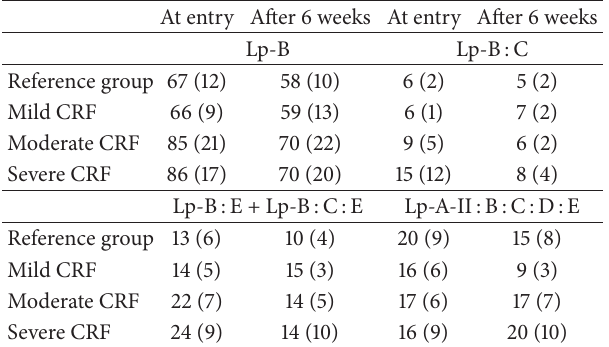
Table 5: Plasma concentrations of Apo-B-containing lipoprotein particles (mg/dL) in patients with various degrees of chronic renal insufficiency(mild; n =7,moderate; 𝑛 = 8 ,severe; 𝑛 = 8 )andhealthy reference subjects ( n = 17) at start and end of treatment with 1mg tesaglitazar o.d. Mean and standard deviation (in